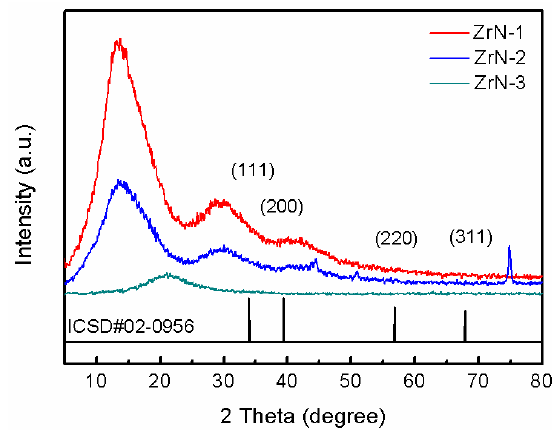
Figure 3. The XRD patterns of the ZrN films deposited at different substrates: ZrN-1 corresponds to the smooth substrate, ZrN-2 represents the drawing surface substrate and ZrN-3 refers to the polished substrate.